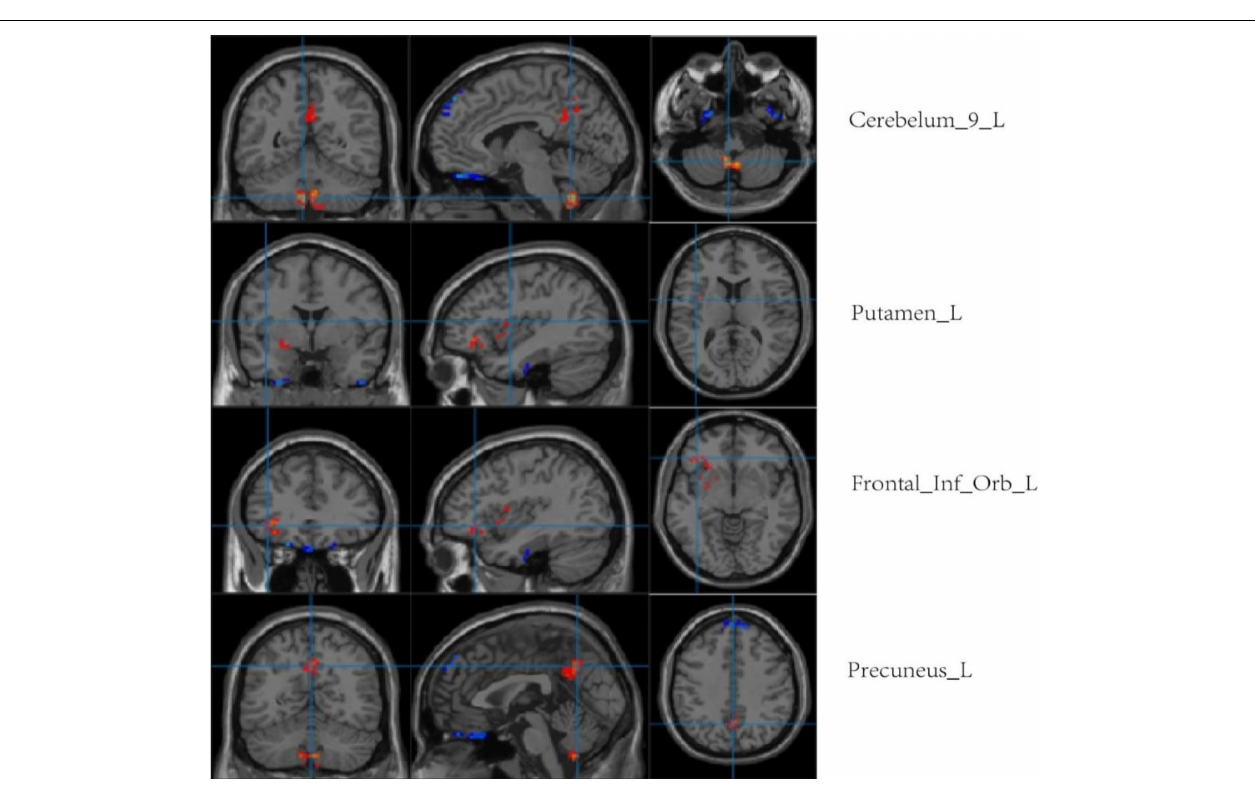
FIGURE 7 | Regional comparison of ALFF values after chronic hypoxia exposure ( p < 0.001, cluster size > 50). Red represents brain regions with reduced ALFF after chronic hypoxia exposure (HA < LA). Blue represents brain regions exposed to chronic hypoxia with elevated ALFF (HA >